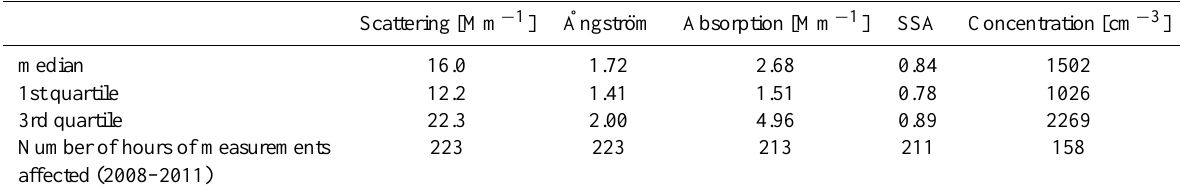
Table 8. Statistics for aerosol particle scattering coefficients (550nm), scattering ˚Angstr¨om exponent, absorption coefficient (637nm), single scattering albedo (637nm) and particle number concentration during episodes of influence of the Manaus urban plume between February 2008 and June